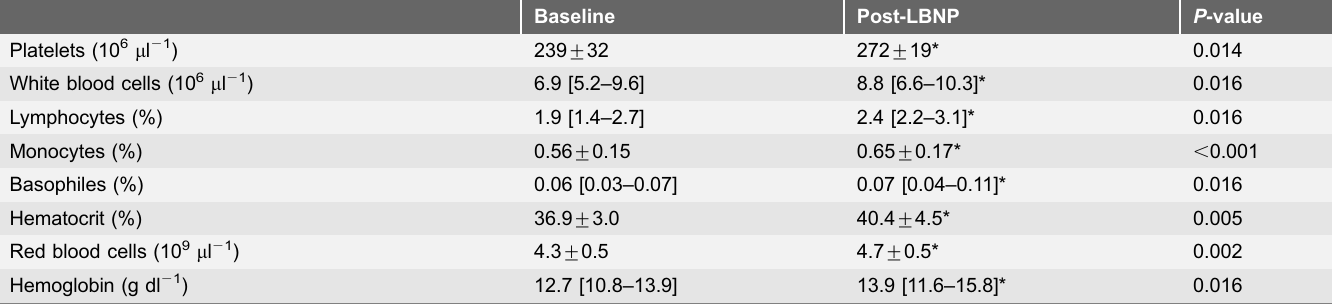
Table 4. Hematology before and 5 min after lower body negative pressure (post-LBNP) was ceased because of presyncopal symptoms.